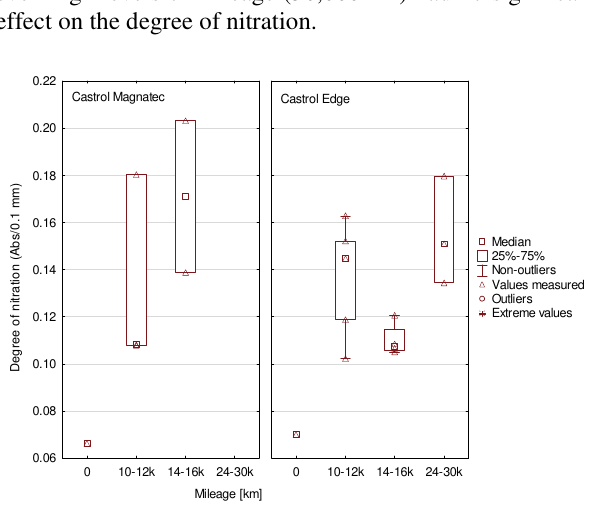
Fig. 6. The degree of nitration of the engine oils tested The next parameter analyzed was the degree of sulfona- tion of used engine oils. This is a process that stems from the reaction of sulfur (mainly contained in fuel) with oxy- gen. As a result of this process, sediment is formed inside the engine, and with addition of water, also sulfuric acid. Sulfonation increases the wear of quality additives in en- gine oils. This is of particular importance if the engines are equipped with an EGR system. The degree of sulfonation of the engine oils tested are presented in Fig. 7.